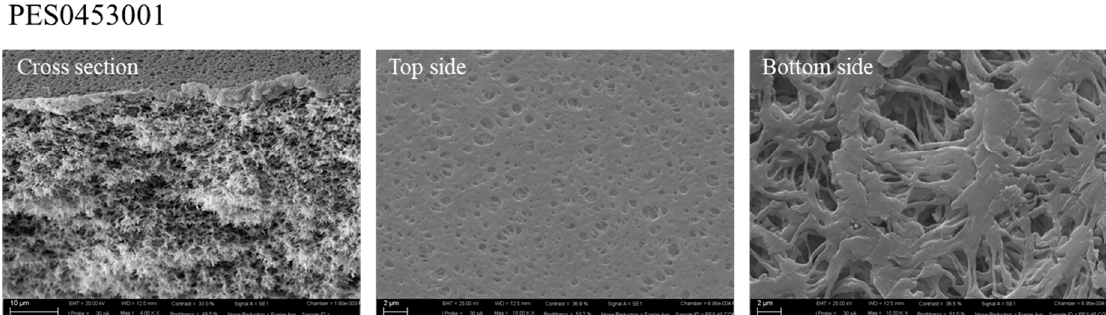
Figure 6. SEM picture of the commercial PES membrane (magnification of 4.00 KX for cross-section and top side, and 10.00 KX for bottom side).